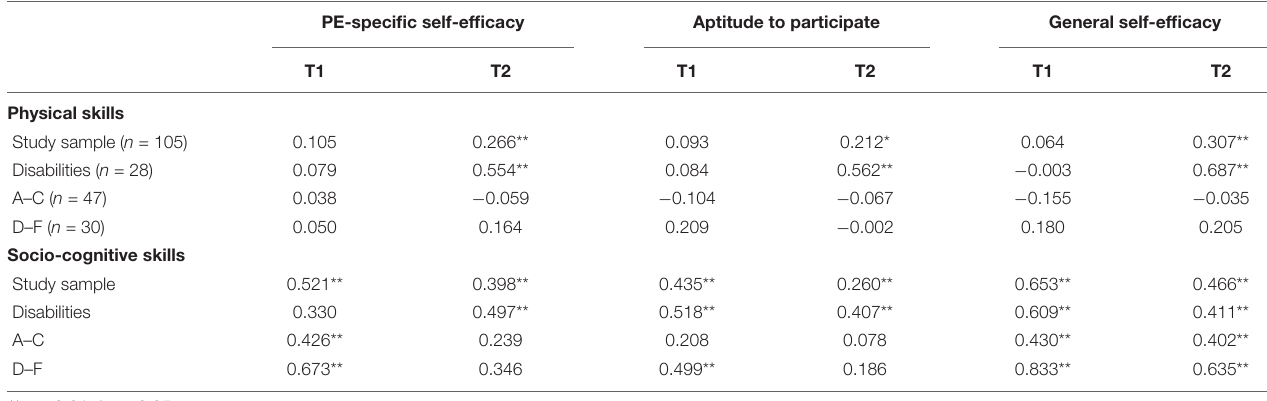
TABLE 4 | Correlations over time between students’ perceived functional skills (physical and socio-cognitive), self-efficacy (PE-specific and general), and aptitude to participate in the study sample and in each group separately. PE-specific self-efficacy Aptitude to participate General self-efficacy